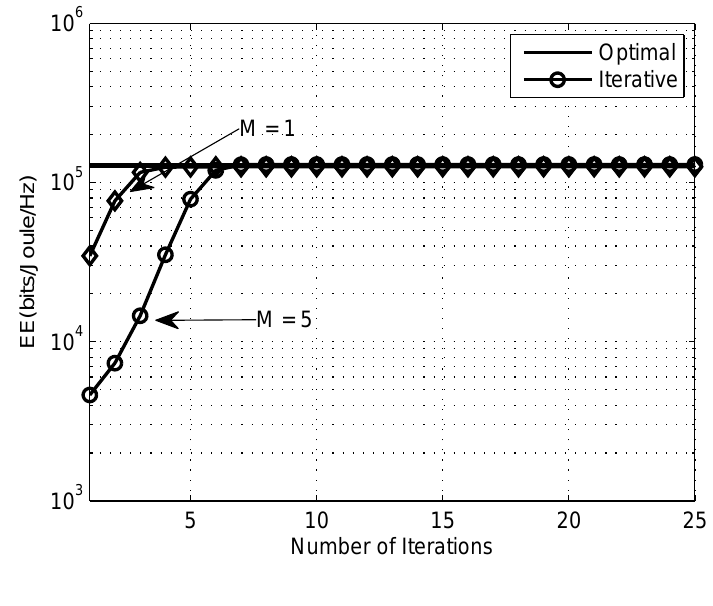
Figure 6. Performance of the iterative algorithm with interference thresholds, I = { 1 µ W, 1 mW } m